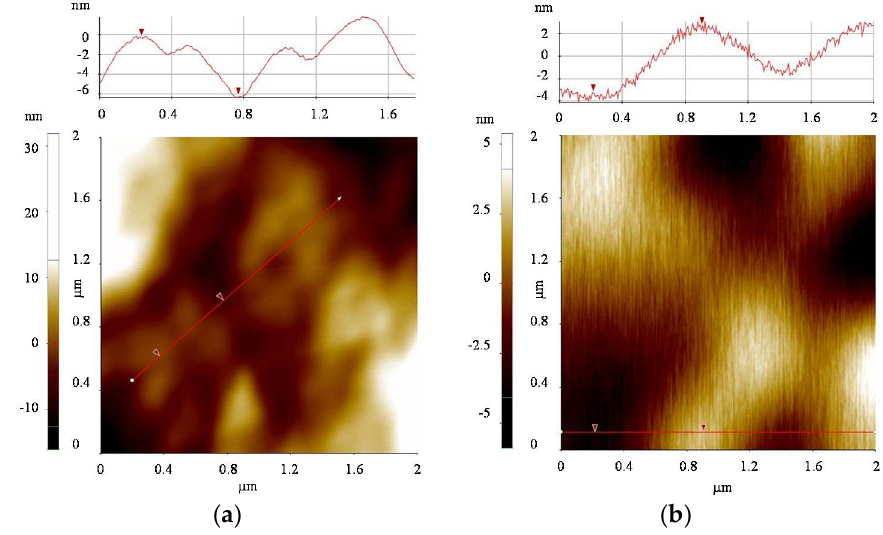
Figure 12. AFM images of ITO/PET sheet: ( a ) as-received; ( b ) after tensile bending with a 5 mm curvature radius for 1000 h.